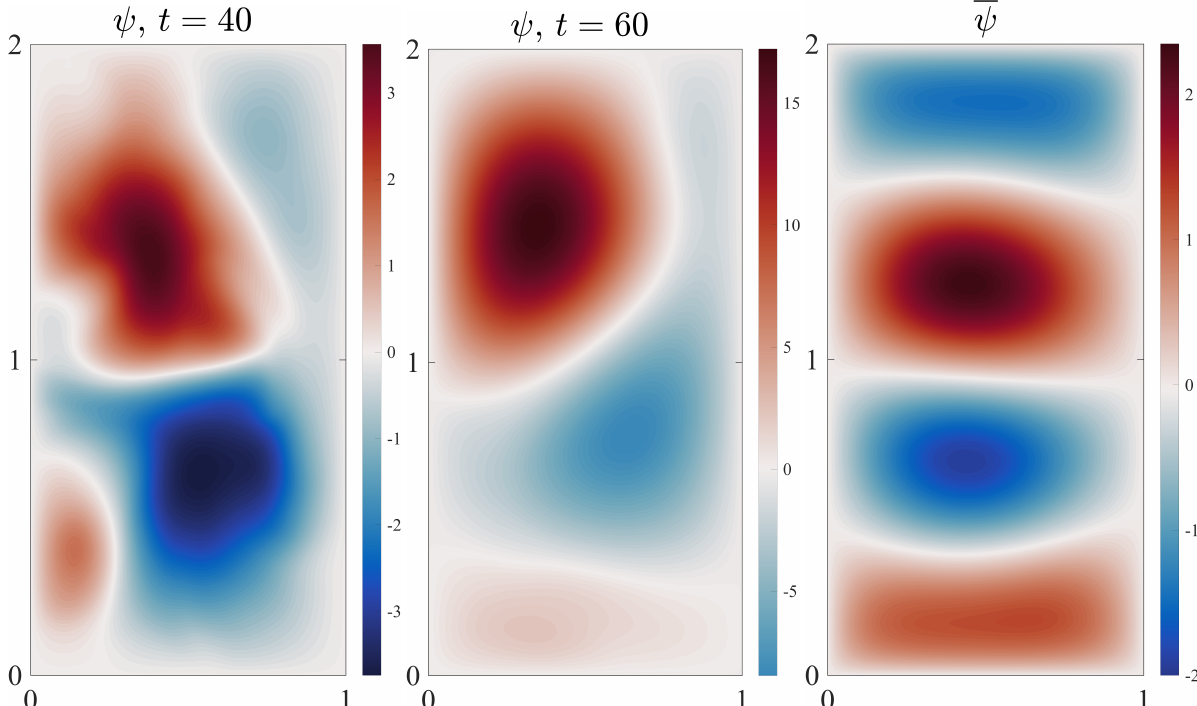
Figure 5. FOM streamfunction contour plots at t = 40 ( left ), t = 60 ( middle ), and time-averaged ( right